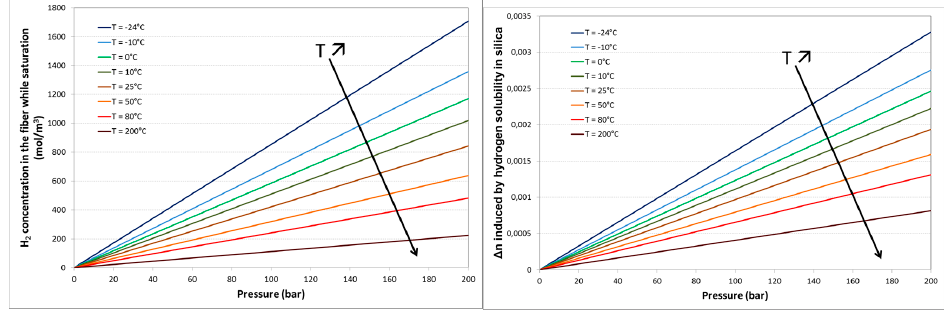
Figure 12. Theoretical values of the pressure and temperature dependence of the H 2 saturation concentration in the fibre core center ( left ) and the related refractive index variation ( right ).